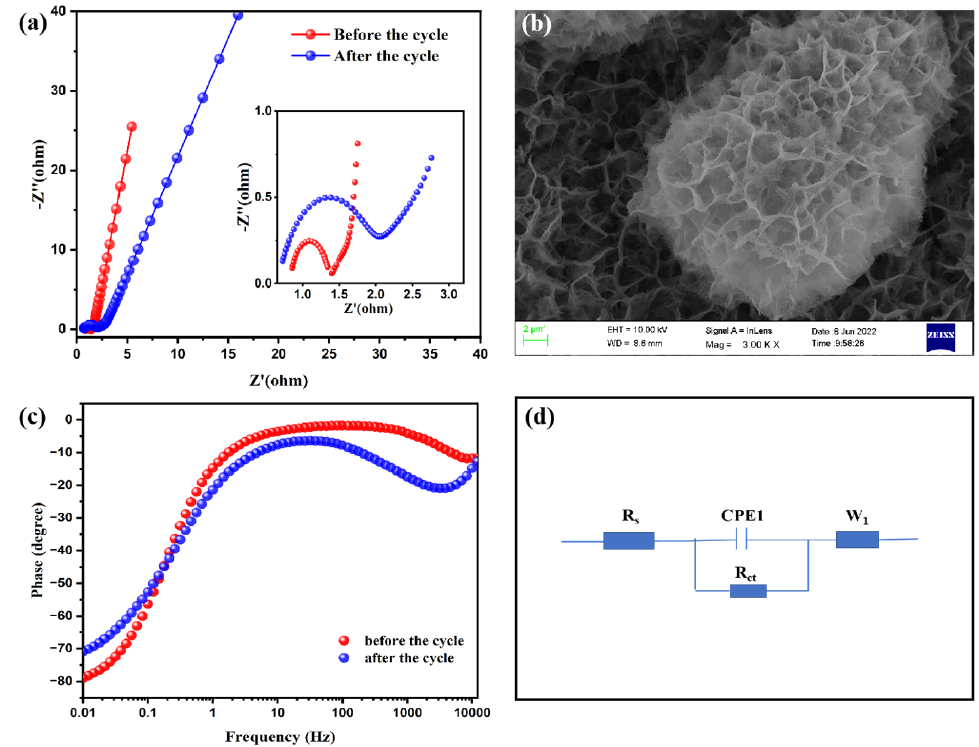
Figure 9. ( a ) the Nyquist plot of the symmetric SC before and after 30,000 cycles, the inset is the plot in the high-frequency region; ( b ) SEM image of the symmetric SC after discharging/charging for 30,000 cycles at a current density of 10 A/g. The electrolyte was 6 mol/L KOH solution; ( c ) Bode phase diagram of the symmetric SC before and after 30,000 cycles; ( d ) the simulated supercapacitor equivalent circuit diagram.